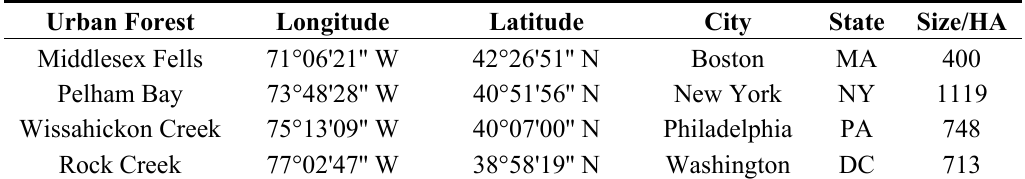
Table 1. Urban Forest, longitude, latitude, county, state and size (in ha). Urban